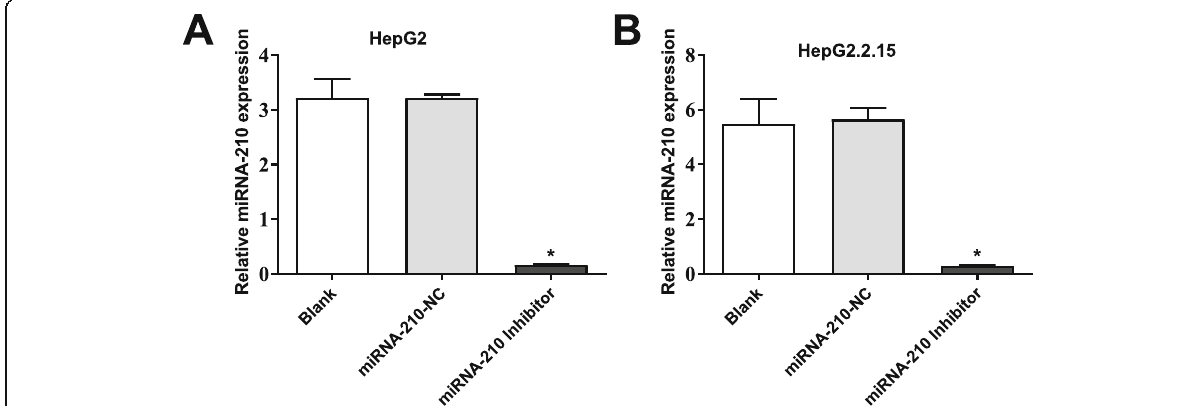
Fig. 2 The transfection of miRNA-210 inhibitor inhibited the expression of miRNA-210 in HepG2 a and HepG2.2.15 b cells. * P < 0.01 compared with the Blank group. The experiment was performed in triplicate, and data were expressed as mean ± standard deviation